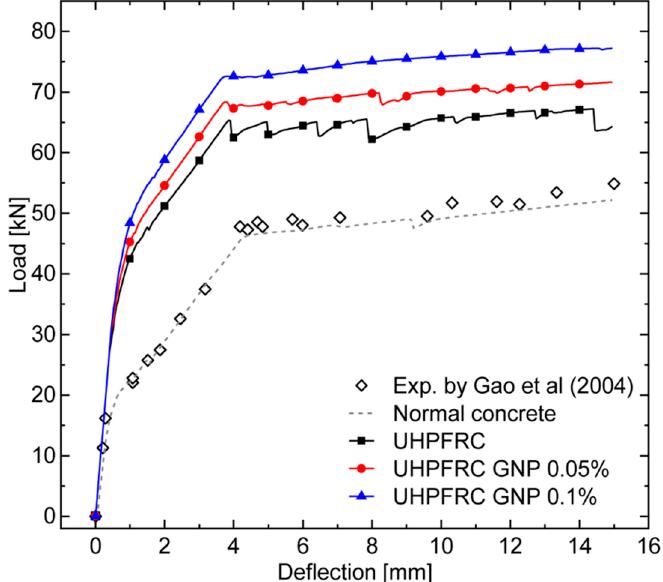
Figure 8. Numerically predicted load versus mid-span deflection curves of steel bar-reinforced UHPFRC beams enhanced with different content of GNPs (0%, 0.05%, and